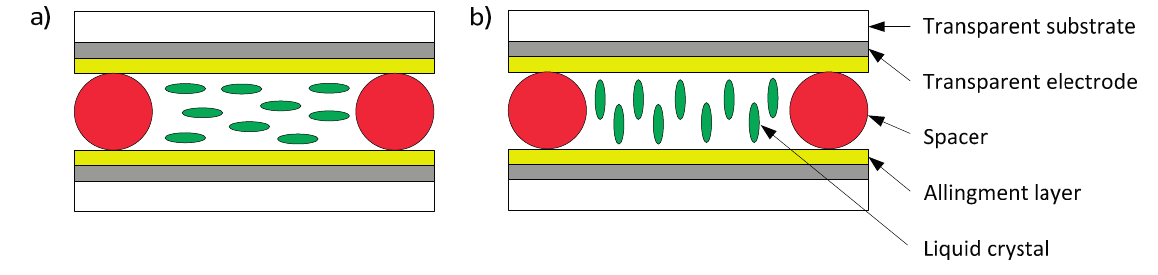
Figure 1. Schematic illustration of alignment in nematic liquid crystal cells, V RMS = 0 V: ( a ) planar alignment; ( b ) homeotropic